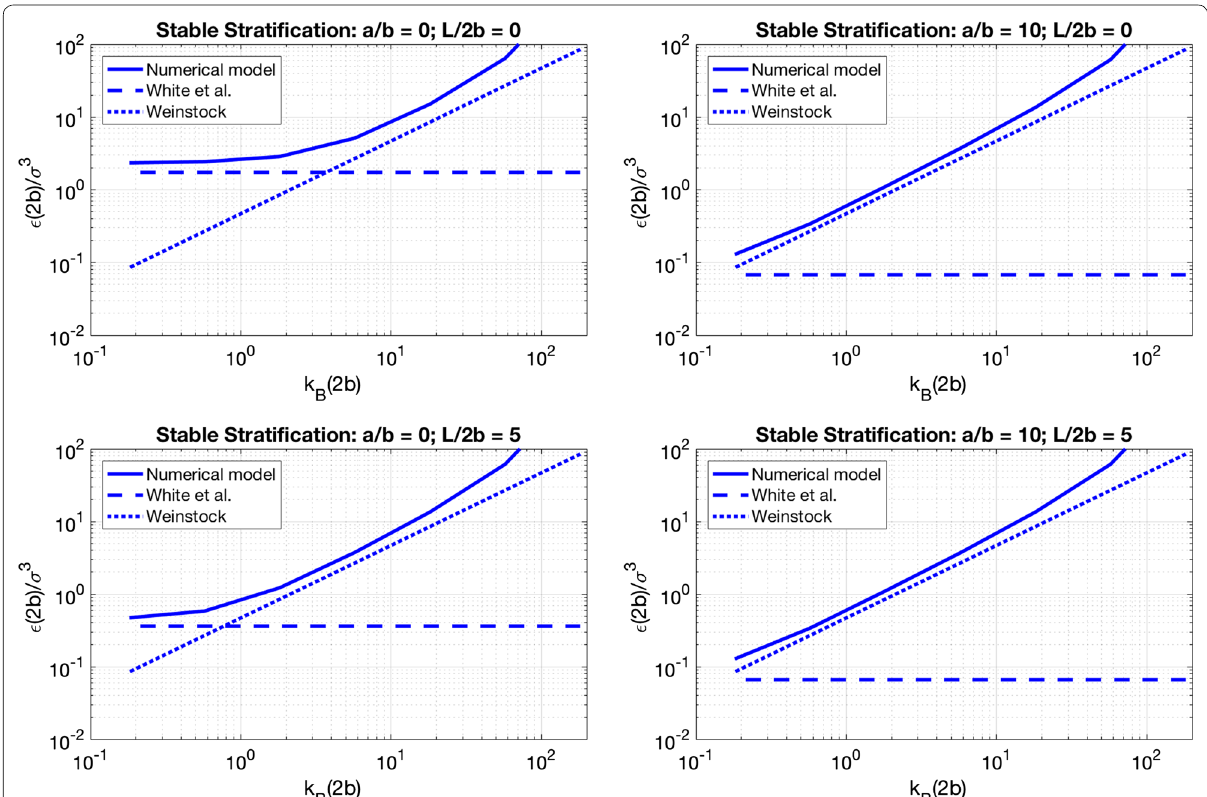
0, Lby2b 0.001 (zero altitude and zero wind). = = 0, Lby2b 5 (nonzero wind). Bottom right: Case = = 0.873 and not equal to 1, the numerical model does not =